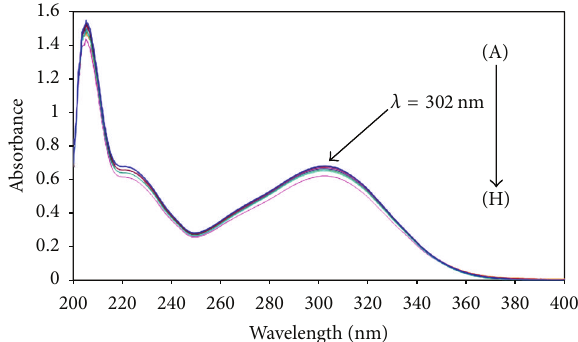
Figure 2: Absorption spectra of Oct (2.77mM) in methanol/water mixture (85 :15, v/v) as a function of 𝛽 -CD’s concentration at 25 ∘ C. [ 𝛽 -CD] (M): (A) 0; (B) 1.51; (C) 3.02; (D) 4.53; (E) 6.04; (F) 7.55; (G) 9.06; (H) 10.57. Stirring time: 6 hours.